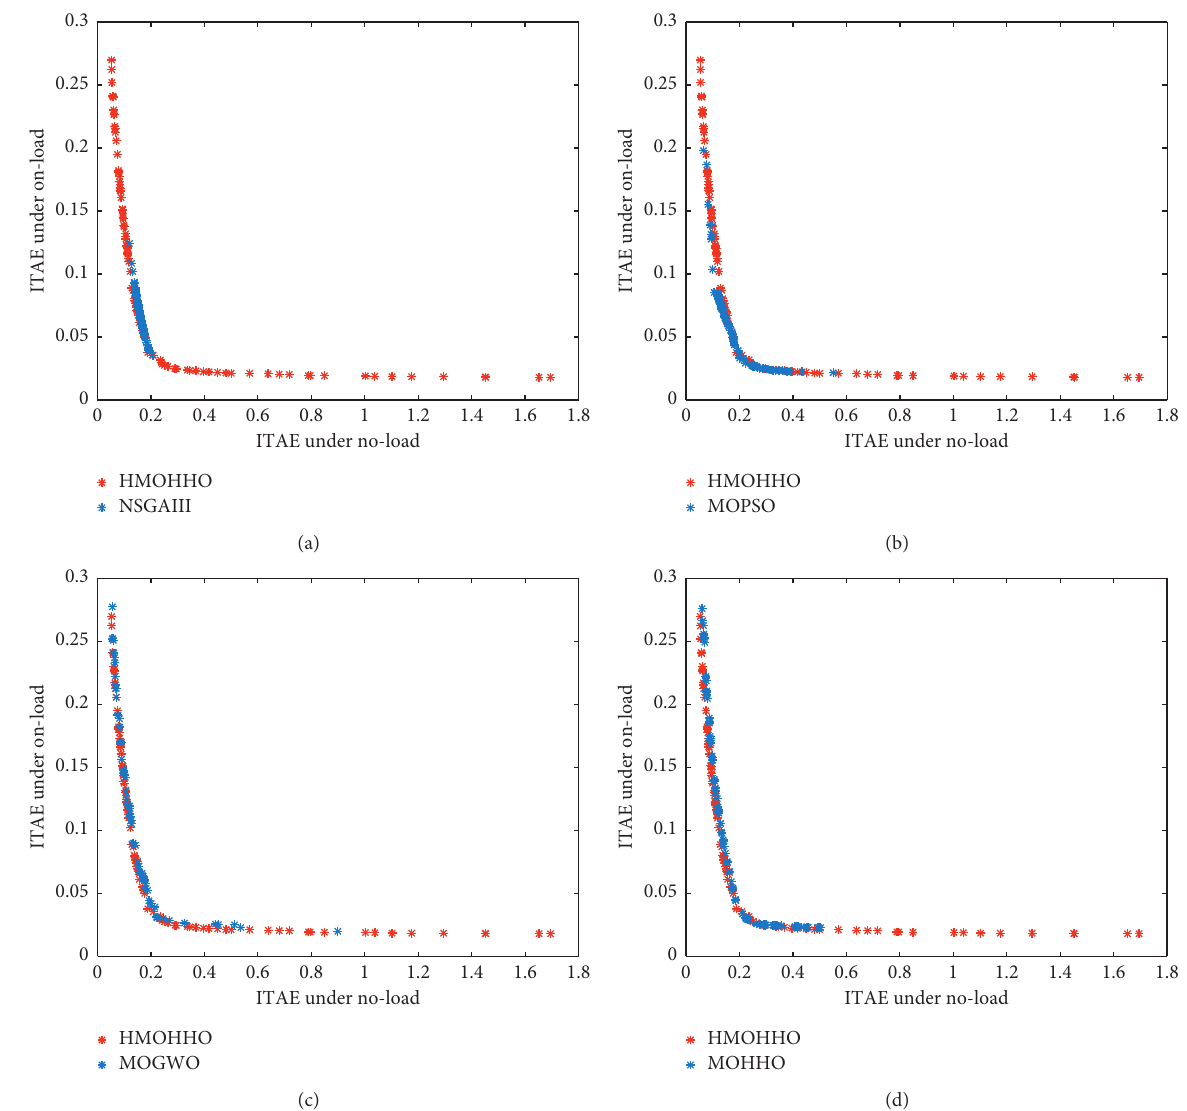
Figure 9: The Pareto fronts of different algorithms. (a) The Pareto fronts of HMOHHO and NSGAIII. (b) The Pareto fronts of HMOHHO and MOPSO. (c) The Pareto fronts of HMOHHO and MOGWO. (d) The Pareto fronts of HMOHHO and